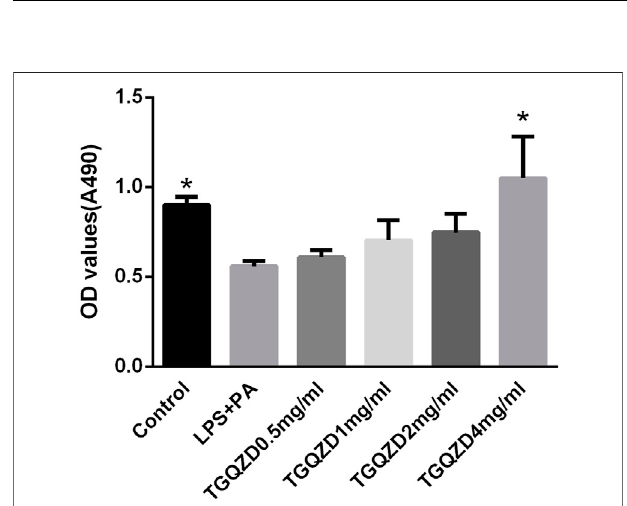
FIGURE 5 | Effects of TGQZD on the viability of HepG-2 cells. HepG-2 cells were treated with 10ug/ml LPS+0.4 mM palmitate and different concentrations of TGQZD for 24 h, and cell viability was measured using the MTT assay. Data are expressed as the mean ± SD (n = 3). * p < 0.05 vs. LPS + PA Group,